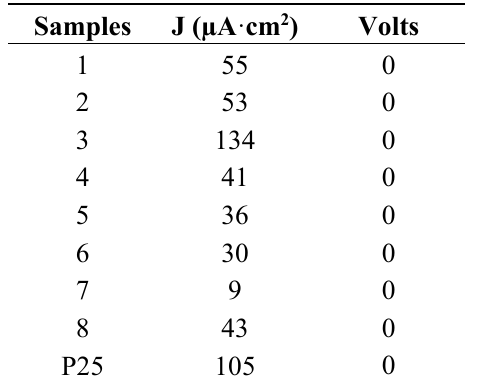
Table 5. Current densities at 0 V vs. Ag/AgCl for samples 1–8 and